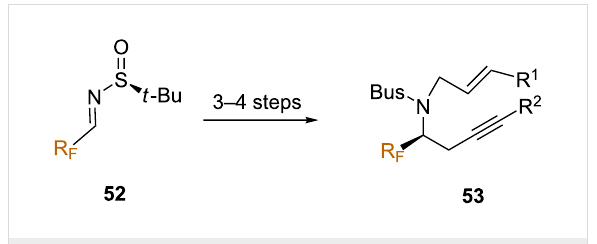
Scheme 27: Asymmetric synthesis the fluorinated enynes 53